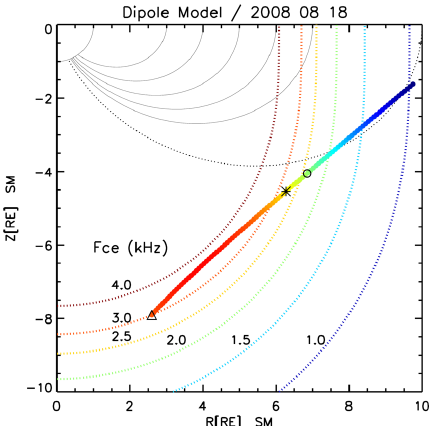
Figure 4. Meridian view, with L shells and isoFce contours of a simple dipolar model, as in Fig. 2. Chosen colours vary from brown ( F c e = 4kHz) to dark blue ( F c e = 1kHz), according to a blue–red colour table. An indicative plasmapause L shell is drawn at L = 10. The Cluster tilted pair at 12:20UT is shown by a triangle. The ray path is traced backward under the free propagation approximation, forming a coloured thick line. The colours reflect local values taken by F c e in the Tsyganenko model (same colour table than used for the isoFce contours in the dipolar model). The indicative position of the source is shown by an asterisk when using the Tsyganenko model, by an open circle when using the dipole model. The MLT value varies from 6.40 at source (in Tsyganenko model) to 4.65 at